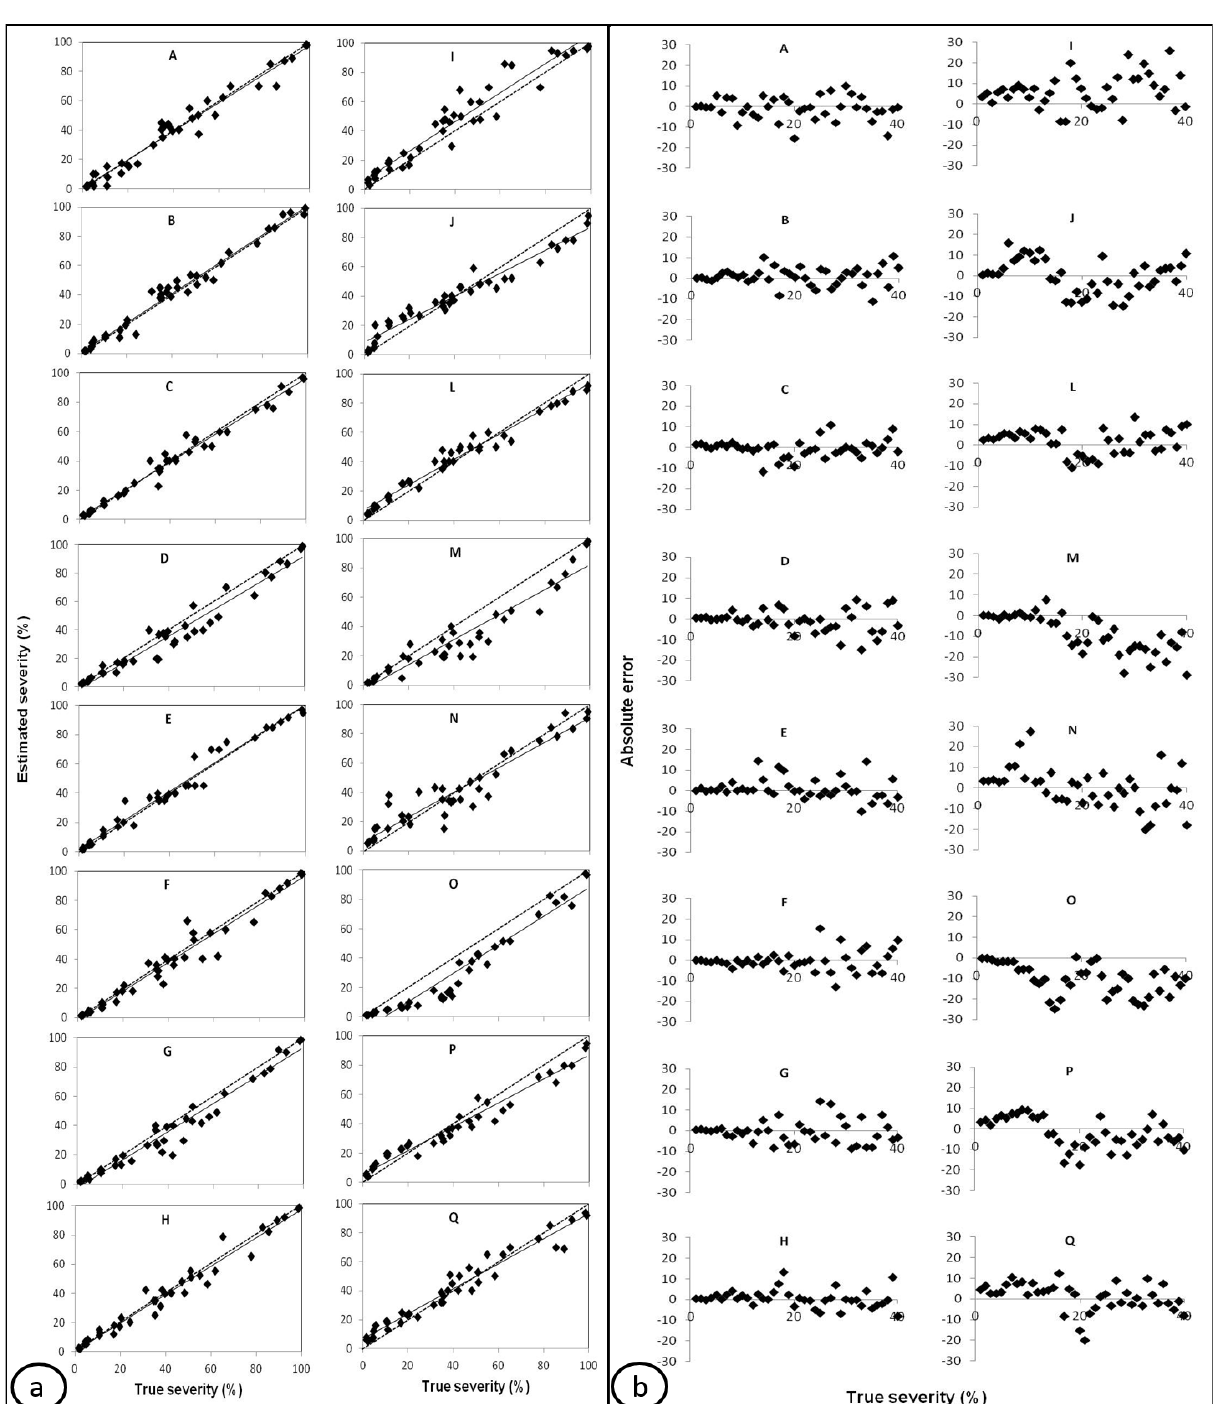
Figure 2. a Estimated severity (unbroken lines) and true severity (dotted lines) for brown leaf spot on leaflets of Carya illinoinensis . A-H: evaluators using the scale. I-Q: evaluators not using scale; b Absolute error (estimated minus true severity) for brown leaf spot on leaflets of Carya illinoinensis . A-H: evaluators using the scale. I-Q: evaluators not using